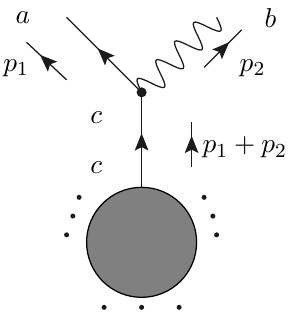
Figure 2 . Feynman diagrams leading to soft gaugino